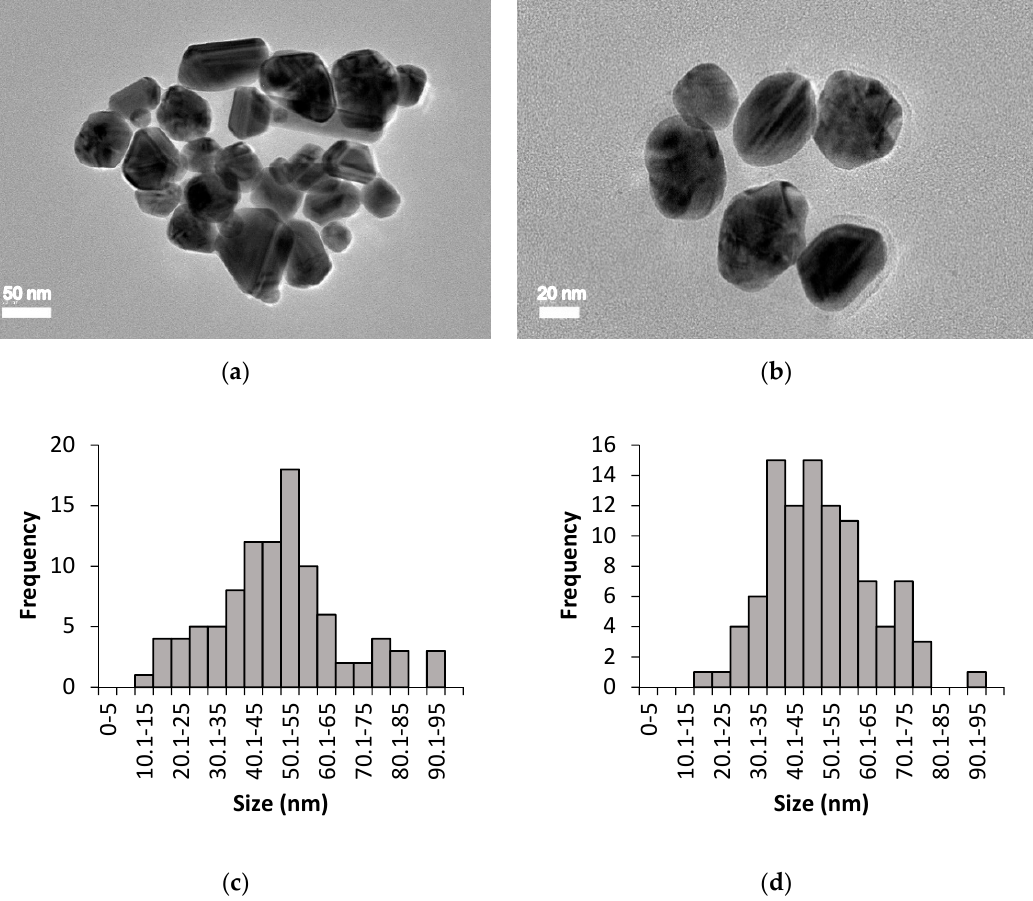
Figure 3. HR-TEM imaging for chemically synthesised AgNPs: ( a ) Uncoated AgNPs, ( b ) PEG-coated AgNPs, ( c ) size distribution of uncoated AgNPs with an average size of 49.26 ± 13.76 nm, and ( d ) size distribution of PEG-coated AgNPs with an average size of 50.43 ± 19.10 nm.